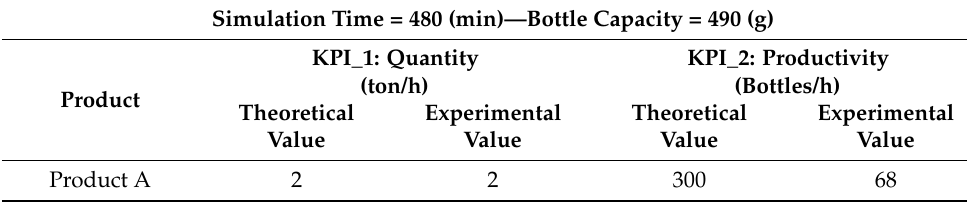
Table 10. Results of Digital Model—Before the Implementation of the Proposed